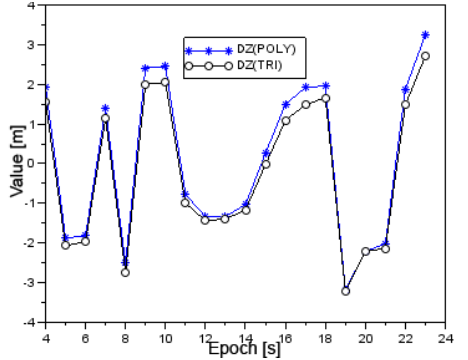
Figure 4. The values of DZ parameter based on polynomial and trigonometric